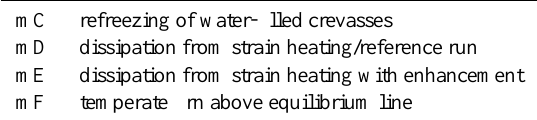
Table 1. Designation of model runs with different heat sources. These sources are combined in different model runs, e.g., run mEC. mC refreezing of water-filled crevasses mD dissipation from strain heating/reference run mE dissipation from strain heating with enhancement mF temperate firn above equilibrium line